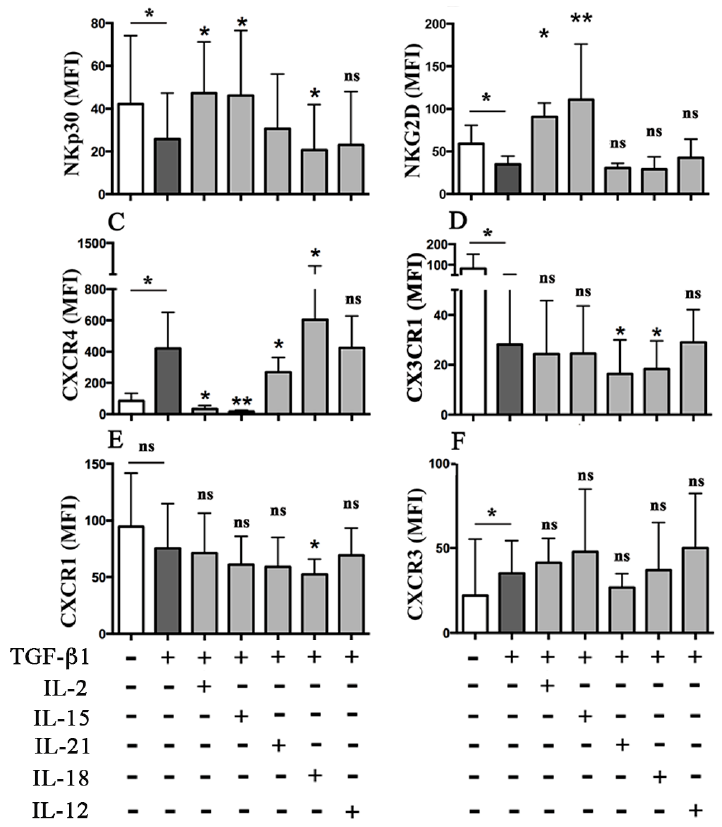
Figure 1. Effect of pro-inflammatory cytokines on the main TGF- β 1-mediated immunomodulatory effects. NK cells purified from peripheral blood of healthy donors (PB NK) were cultured for 48 h either in the absence or in the presence of TGF- β 1 used alone or in combination with the indicated cytokines. Cells were analyzed by flow cytometry for the expression of activating and chemokine receptors. Average of six independent experiments (six unrelated healthy donors). Mean fluorescence intensity (MFI) and 95% confidence intervals are shown. ns: not significant, * p < 0.05, ** p < 0.01. If not indicated, statistical significance is referred to results obtained with TGF- β 1